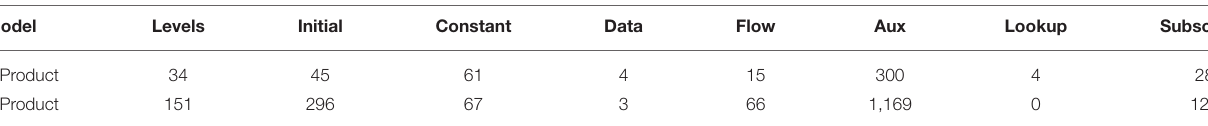
TABLE 1 | Model type